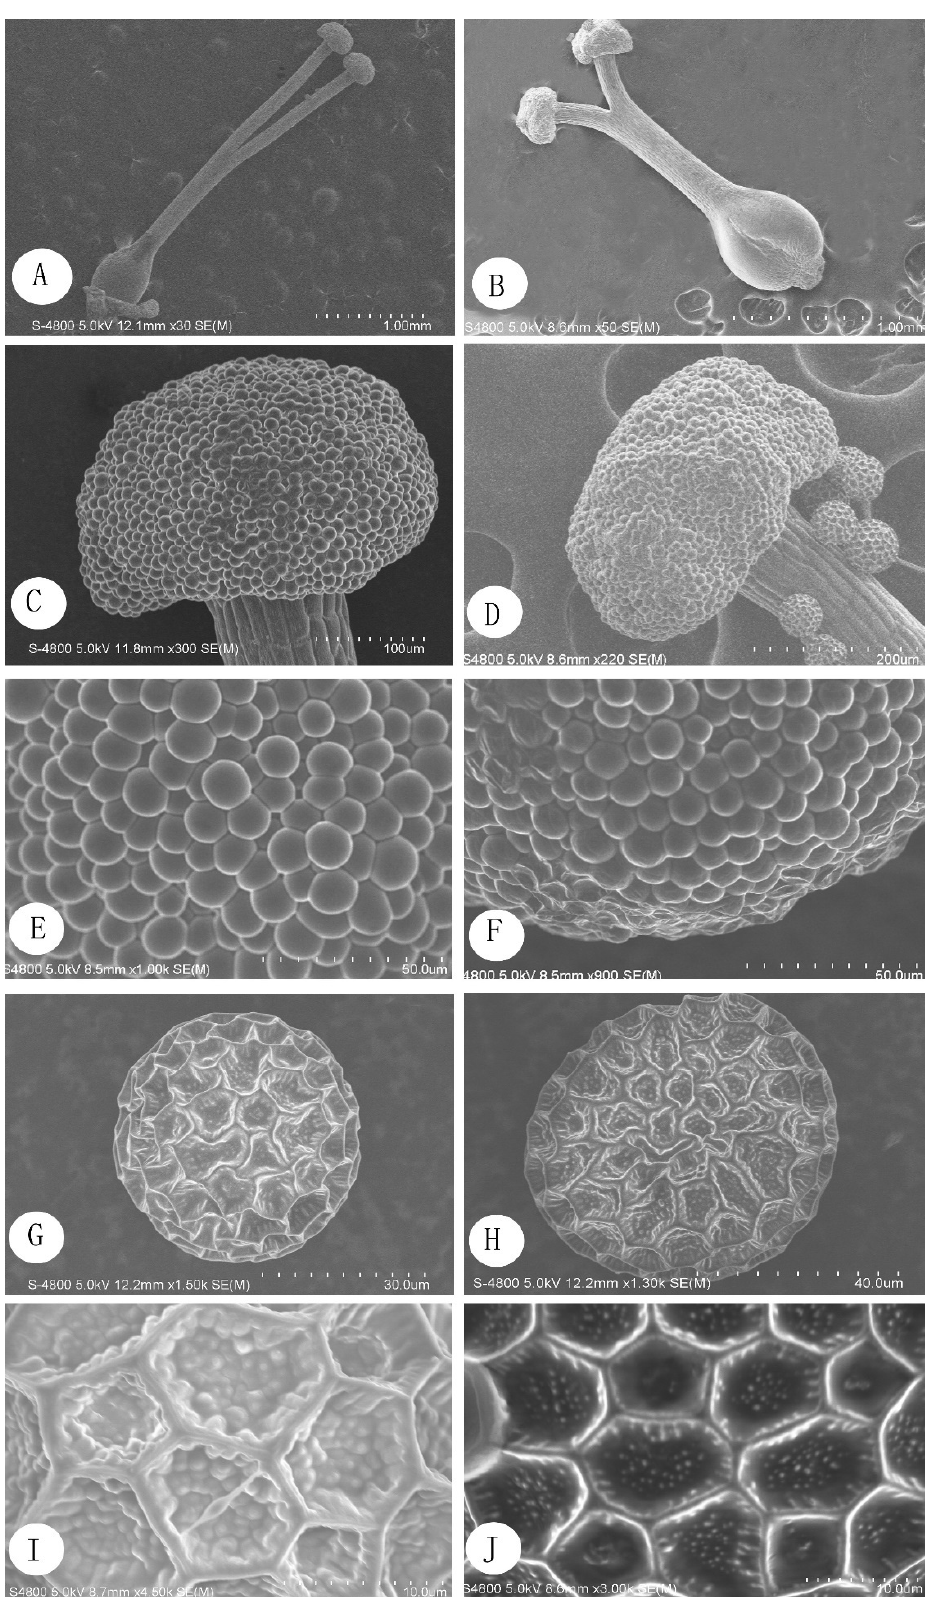
Figure 5. Micromorphological characteristics of P. criopolitanum (SEM). ( A ) pistil of L-morph; ( B ) pistil of S-morph; ( C ) stigma of L-morph; ( D ) stigma of S-morph; ( E ) stigma papillae of L-morph; ( F ) stigma papillae of S-morph; ( G ) pollen of L-morph; ( H ) pollen of S-morph; ( I ) pollen epidermal ornamentation of L-morph; ( J ) pollen epidermal ornamentation of S-morph.